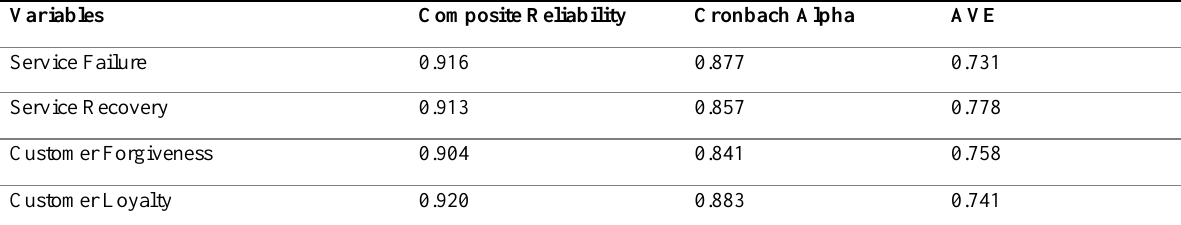
Table 1 : Composite Reliability, Cronbach Alpha, AVE